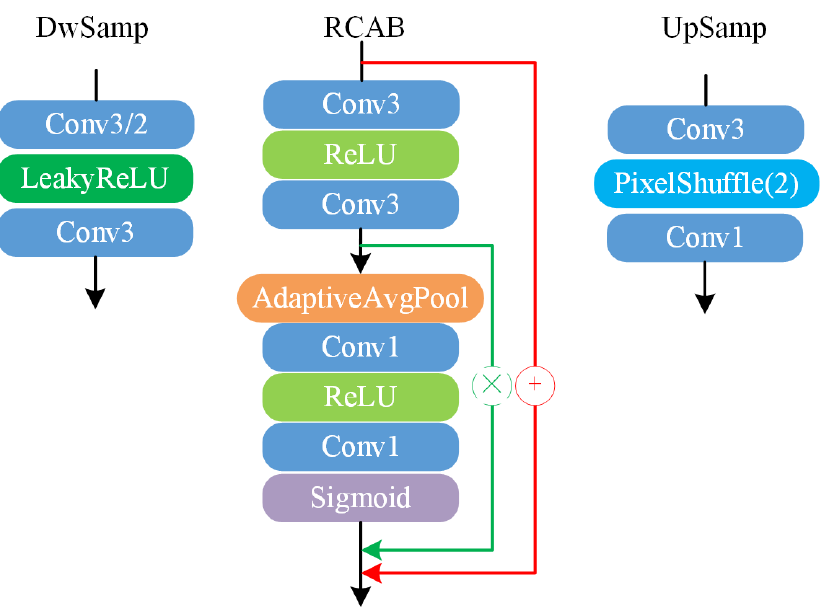
Figure 6. Blocks in DRN.